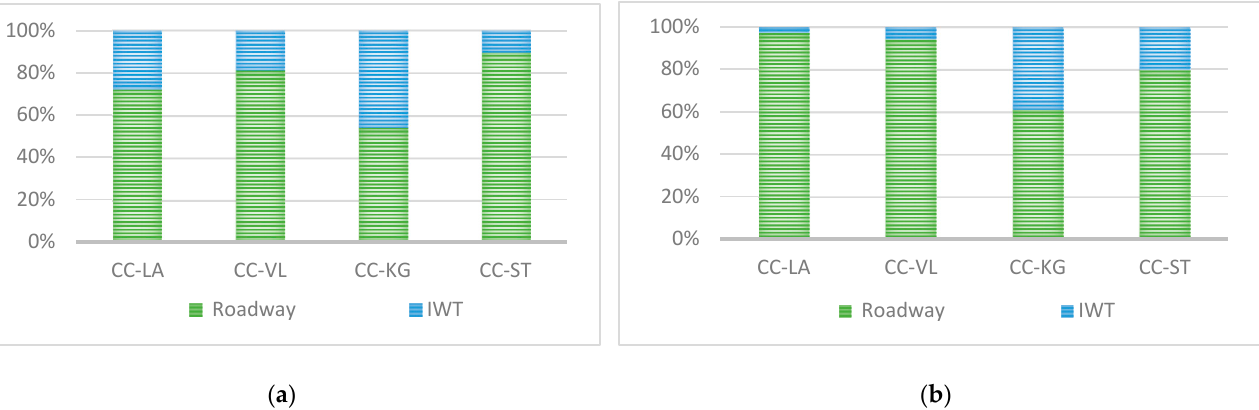
Figure 8. Proportion of transport modes at crossdocking center. ( a ) Receiving flow; ( b ) shipping flow.